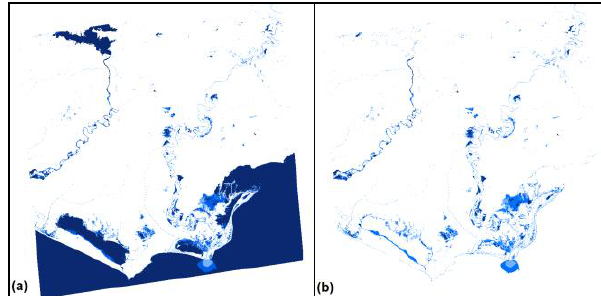
Figure 9. Target masking results, (a) water bodies and flooded areas, (b) flooded areas and rivers after open water